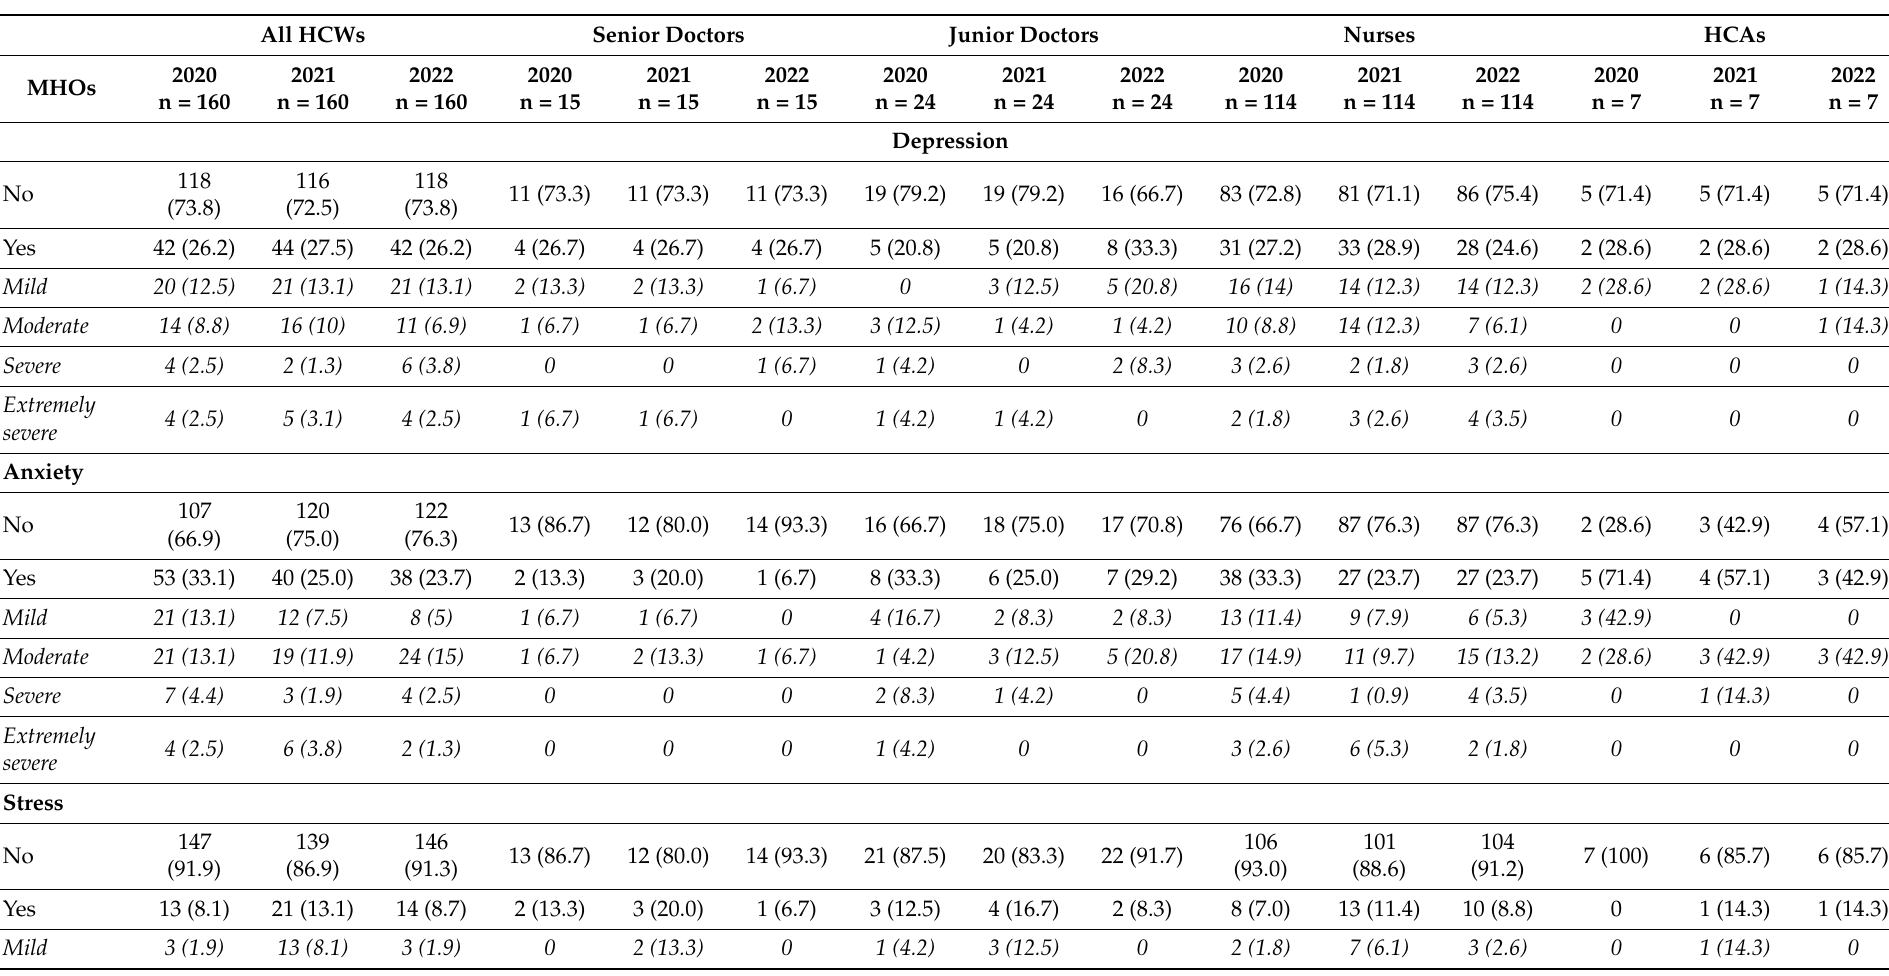
Table A5. Distribution of the different severities of depression, anxiety, stress and PTSD of clinical concern amongst the 160 matched ED HCWs. Depression, Anxiety, Stress and PTSD scores amongst the matched HCWs (n =